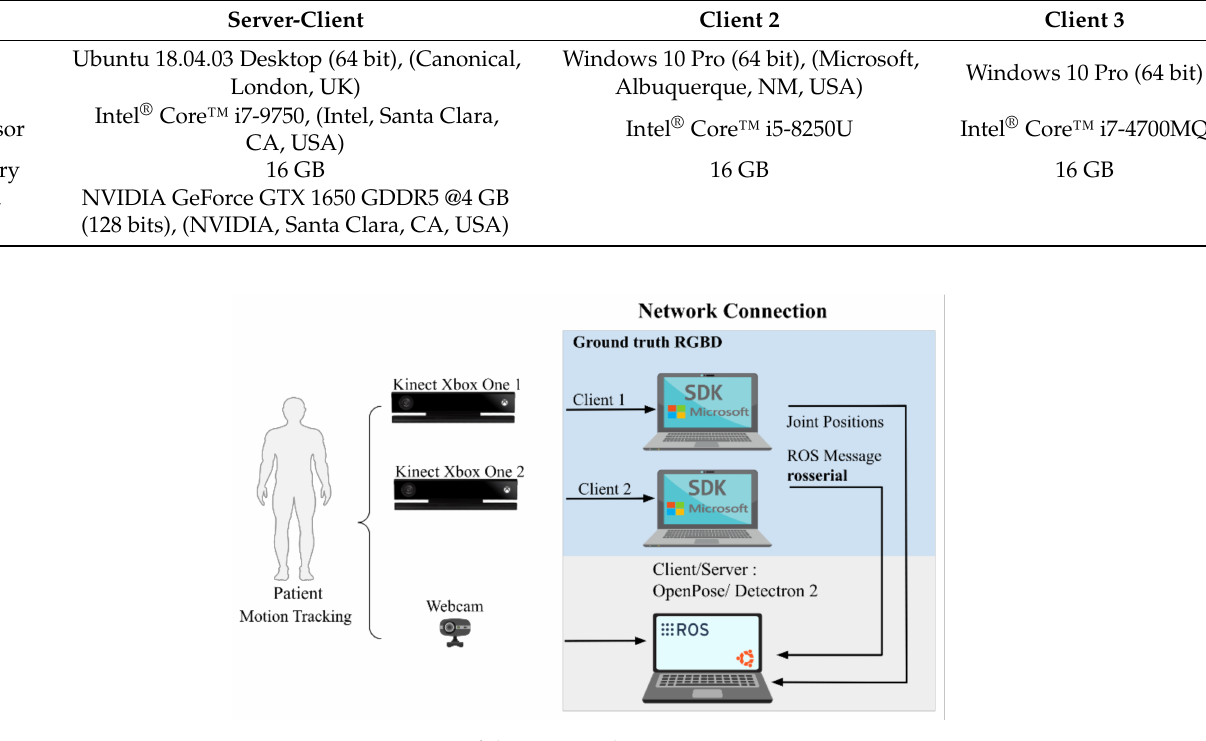
Figure 1. An overview of the proposed